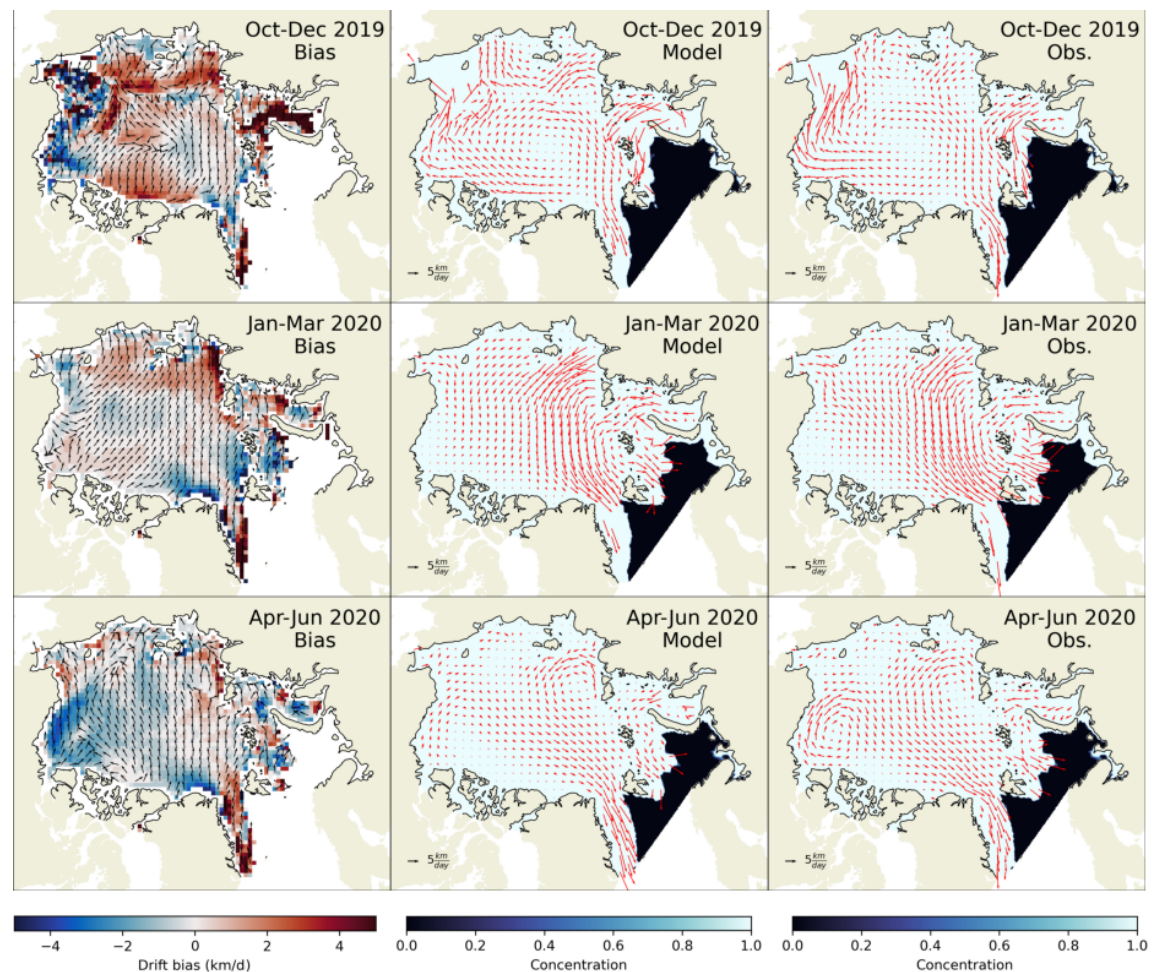
Figure 8. Comparisons of 2-monthly-averaged model and OSI SAF drift from the 2019–2020 winter. The drift bias colour maps (left column) show the bias in speed, while the directions show the difference between the model and observation directions (arrows pointing up indicate the directions are the same). The central column shows ice velocity vectors from neXtSIM, while the right-hand column shows OSI SAF vectors. The concentration colour maps show the average neXtSIM concentration over the analysis period. The bias is defined as modelled speed minus observed